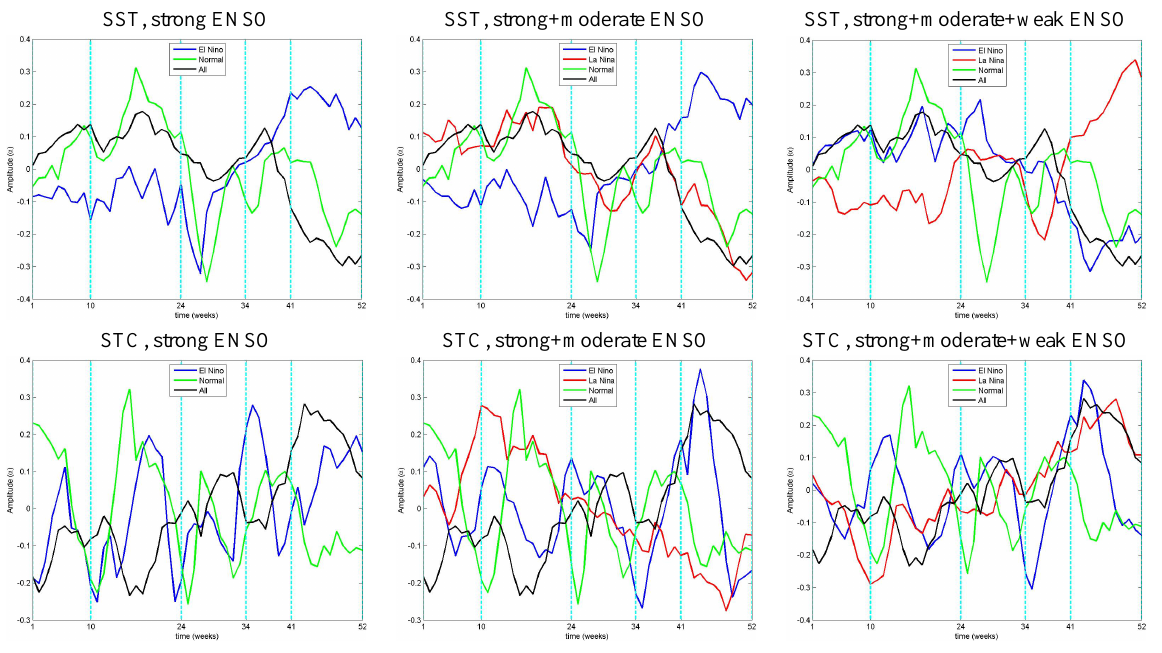
Fig. 12. Time-dependent amplitudes of the second most dominant mode obtained from EOF analysis of SST (top) and STC values (bottom). Strong El Ni˜no and La Ni˜na years (left column), strong + moderate (middle column) and strong + moderate + weak ENSO years are used (Table 1). In all plots, the normal and all year groups do not vary (Table 1). STC parameters: s = 3, c = 3 and moving average threshold j = 2. There is only one strong La Ni˜na year hence its EOF does not have mode 2 (left